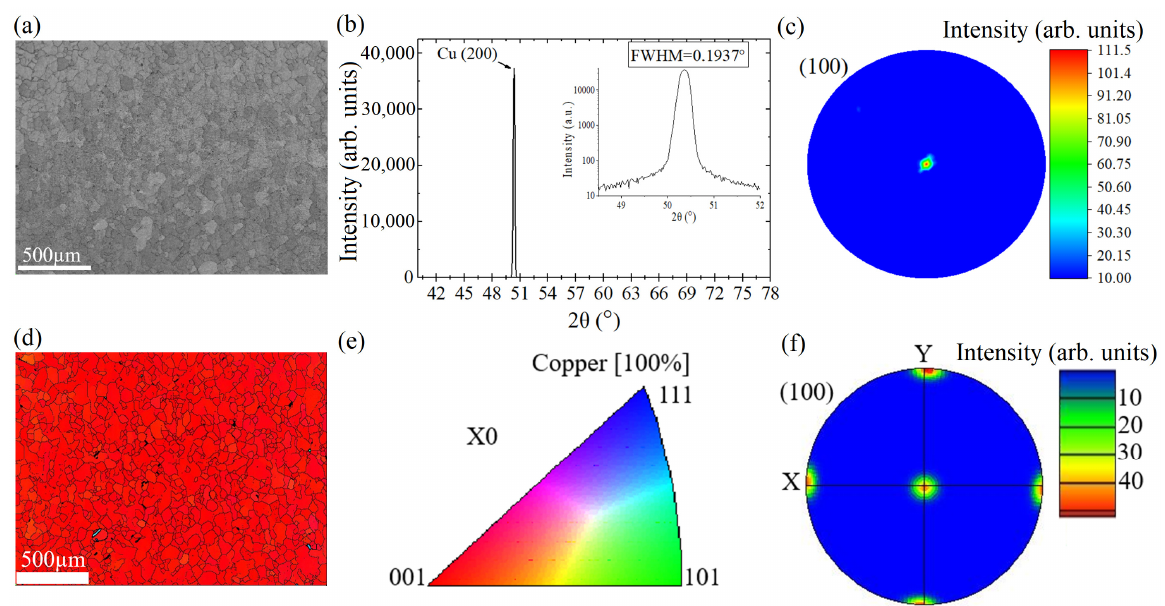
Figure 1. ( a ) SEM image of the 25 μ m Cu foil: ( b , c ) X-ray diffraction θ -2 θ spectrum and pole figure of a Cu (100) sample after graphene growth; the inset shows the rocking curve for the Cu (100) diffraction; ( d – f ) EBSD analysis of the Cu foil after graphene growth; ( d ) the crystallographic orientation mapping in direction normal to the sample surface; ( e ) The color code for this map is given in the stereographic triangle; ( f ) The corresponding pole figure in [001]-direction (i.e., normal to the sample surface).